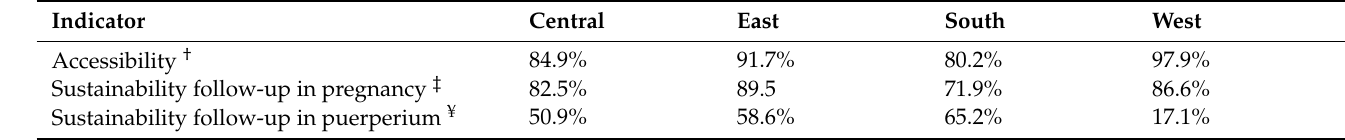
Table 5. Accessibility to the healthcare system in Africa by